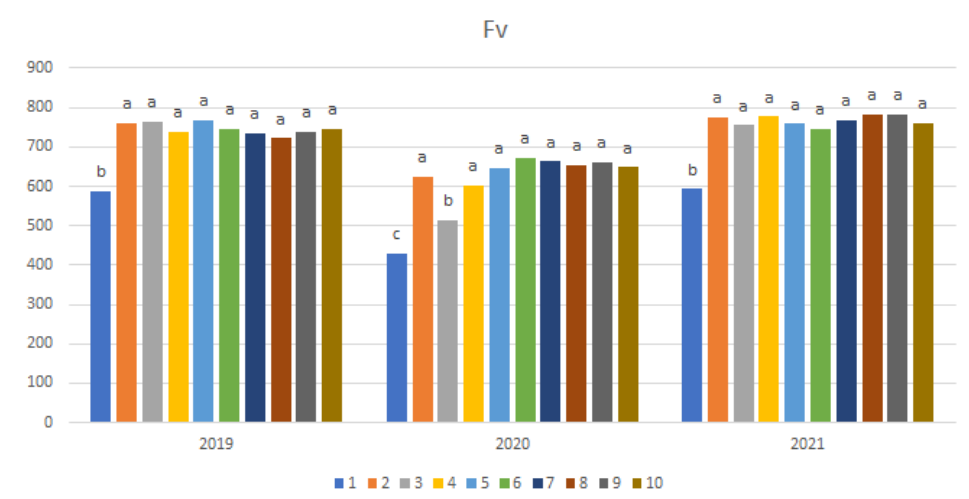
Figure 3. Fm (maximum fluorescence) results for maize in individual years of research. Different letters indicate statistically different mean LSD (0.05): 2019 = 85.29; 2020 = 62.31; 2021 = 102.31. The combination numbers are as specified in Tables 5 and 6.